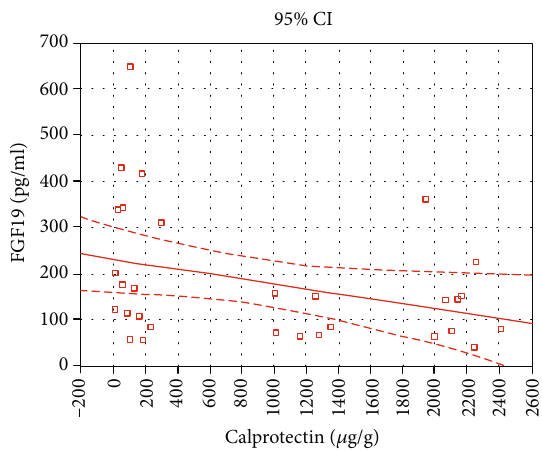
Figure 2: Correlation between serum FGF19 and fecal calprotectin levels in ulcerative colitis. The inverse correlation between serum FGF19 and fecal calprotectin levels was observed in UC patients ( n = 31 ) ( R = – 0 : 38 , p = 0 : 036 ).